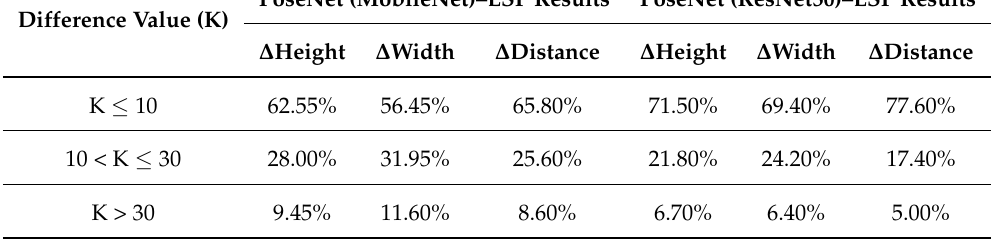
Table 2. The percentage of total images in every difference range by putting the results of PoseNet two architectures and LSP into the designed algorithms to compare